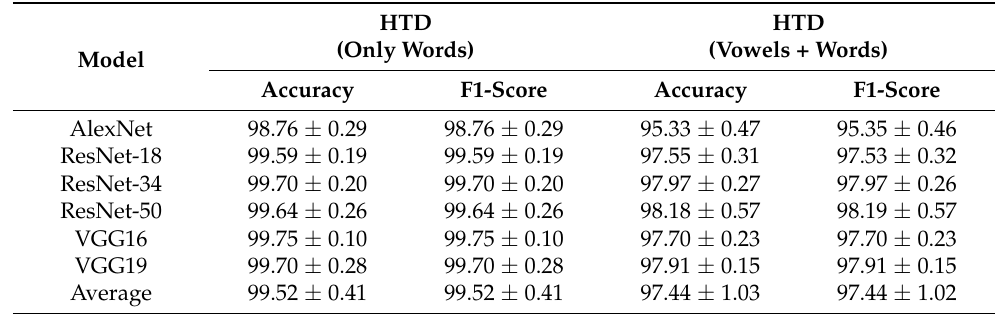
Table 4. Performance evaluation of six state-of-the-art CNN architectures for the classification of only words (20 classes) and vowels + words (26 classes) healthy datasets in terms of accuracy and F1-score using five-fold cross-validation.